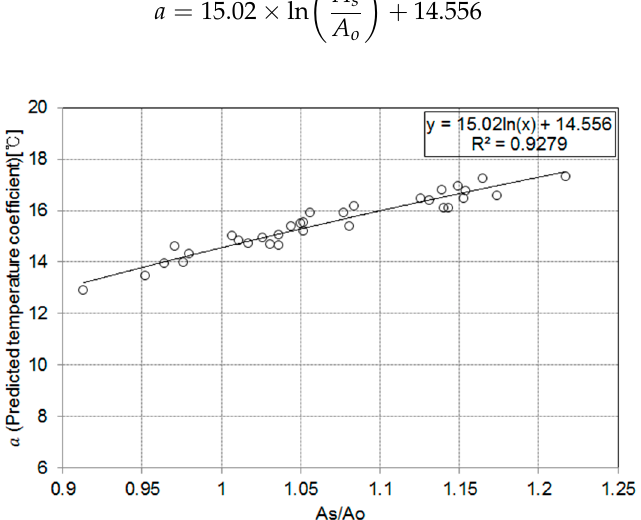
Figure 2. Regression analysis to determine temperature coefficient a with respect to the amplitude ratio Figure 2 . Regression analysis to determine temperature coefficient 𝑎 with respect to the amplitude ( A s / A o ) at nine points provided by the Korea Meteorological Administration ratio ( 𝐴 (cid:3046) /𝐴 (cid:3042) ) at nine points provided by the Korea Meteorological Administration (KMA).